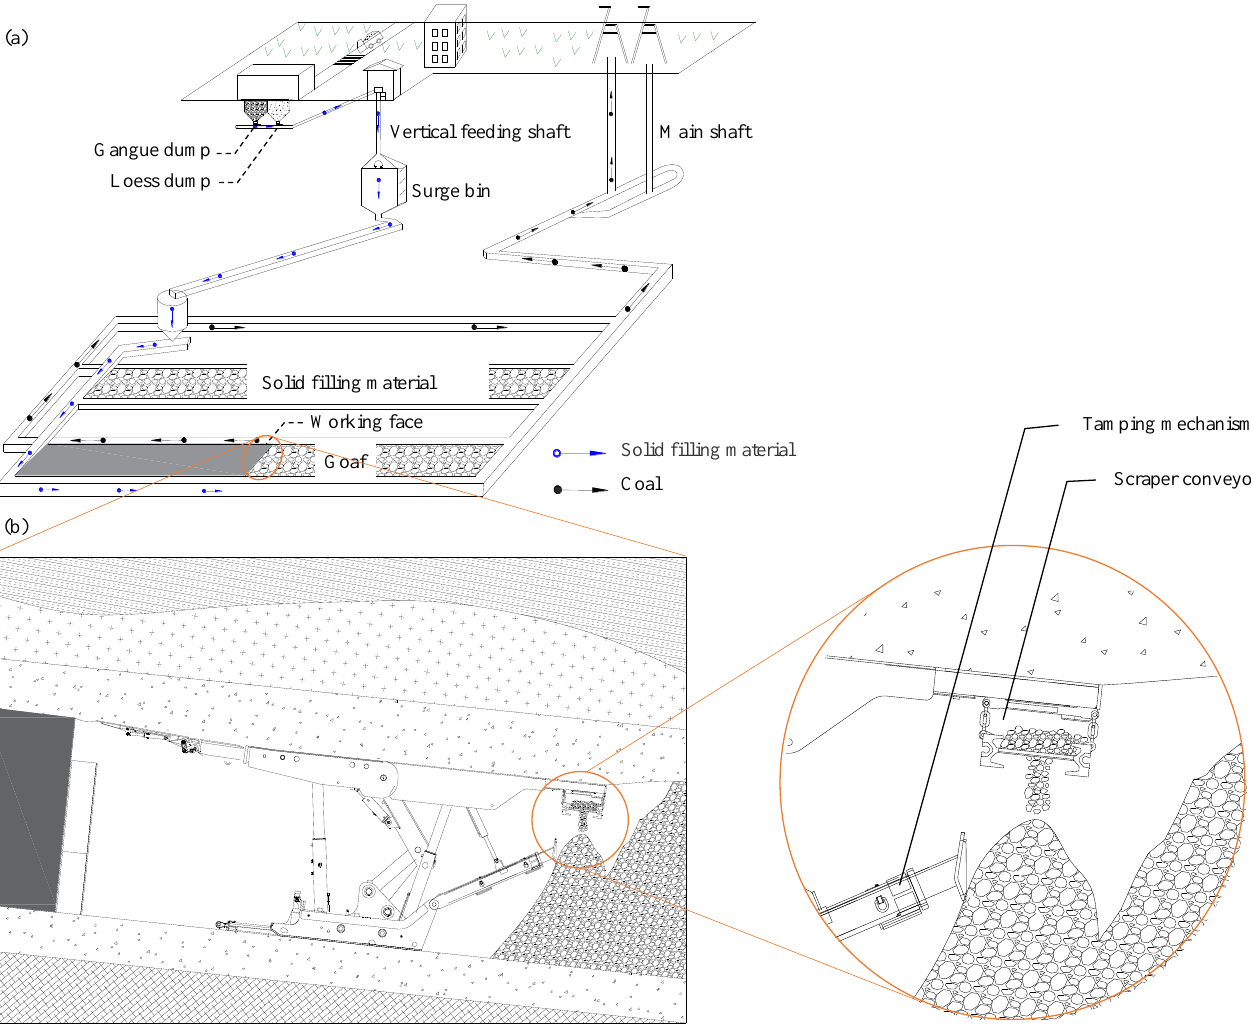
Figure 1. Basic principle of solid backfill mining: ( a ) transportation route; ( b ) basic principle of backfilling hydraulic support.